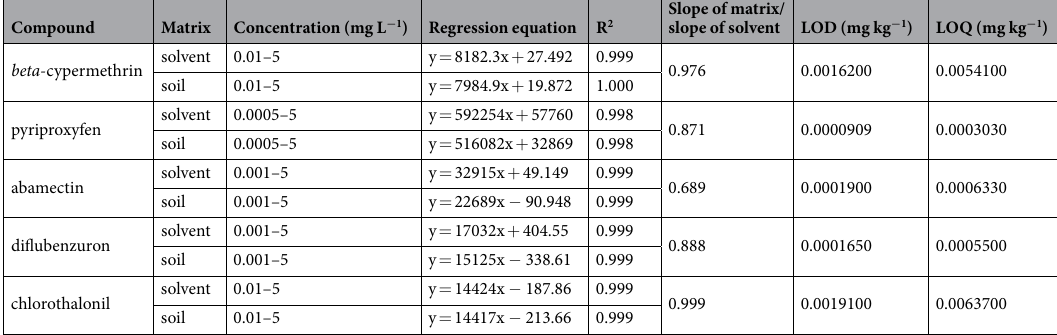
Table 1. Comparison of matrix-matched calibration and solvent